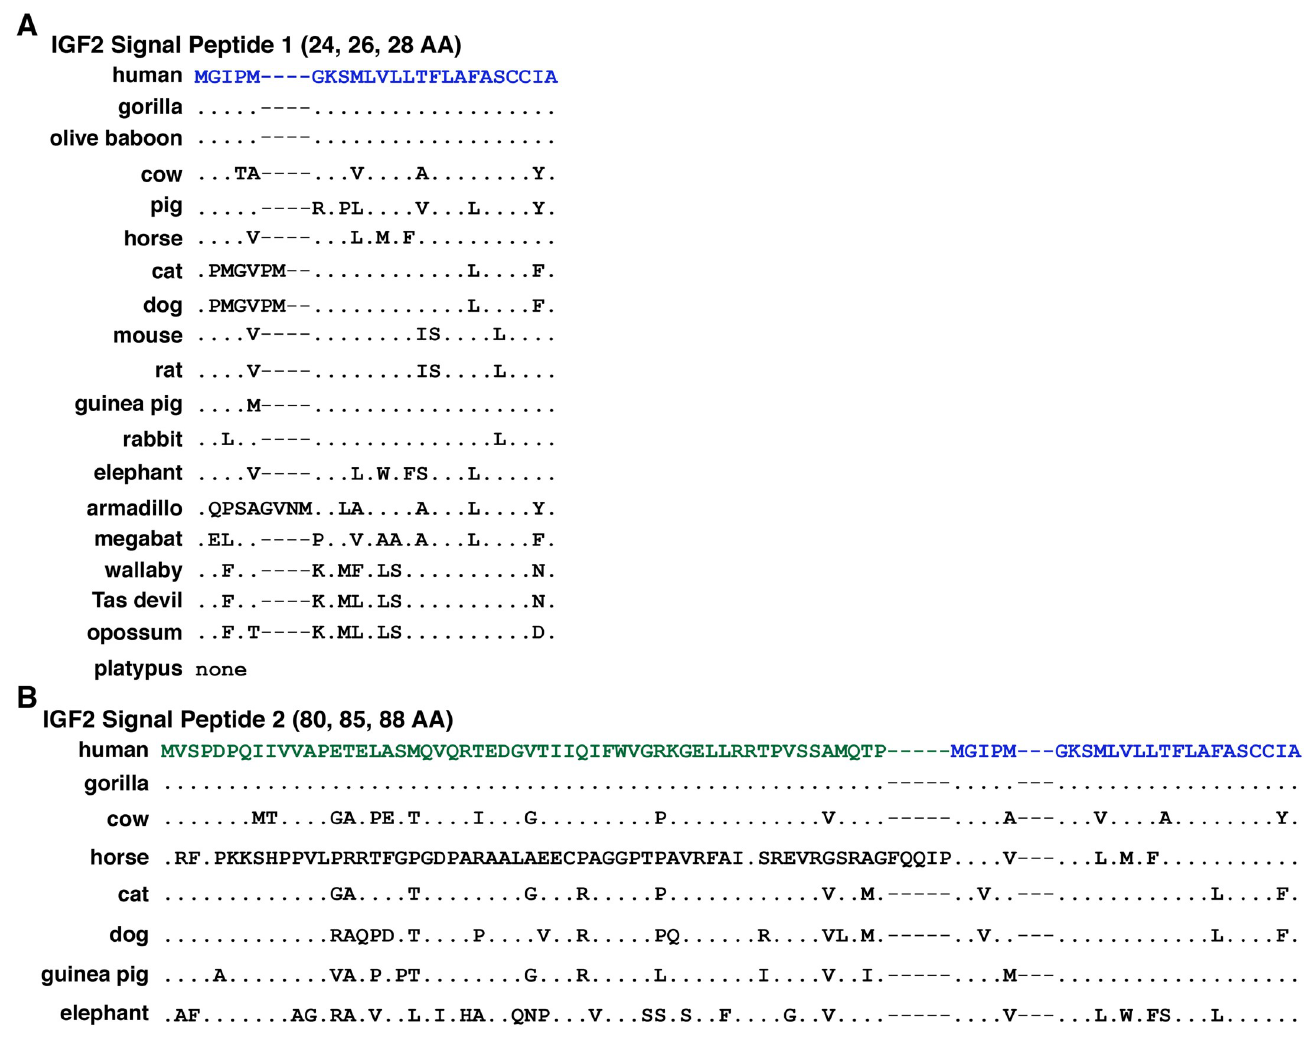
Fig 8. Alignments of IGF2 signal peptides. Amino acid sequences of IGF2 signal peptides from 19 mammals are shown in single letter code. A . 24-, 26-, or 28-residue IGF2 signal peptide 1 is found in all species except platypus. B . 80-, 85-, or 88-amino acid presumptive IGF2 signal peptide 2 can be detected only in human, gorilla, cow, horse, cat, dog, guinea pig, elephant, and platypus. The last 24 residues are identical to signal peptide 1 in human, gorilla, cow, horse, cat, dog, guinea pig, and elephant. For A and B, dots depict identities, dashes indicate no residues, and differences among species are shown. Note that in the platypus Igf2 gene, only a larger signal peptide is predicted that is unrelated in amino acid sequence to other the species